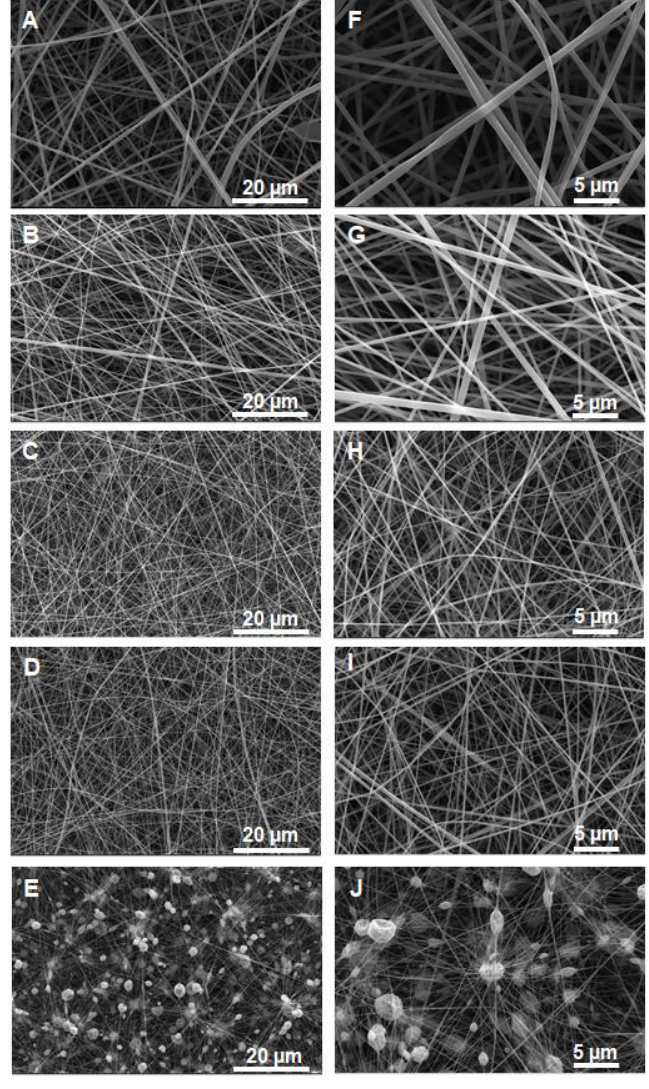
Figure 2. FE-SEM micrographs of pristine P4VPy nanofibers ( A ) and P4Vpy/PP4VpyNTf 2 − nanofibers with PIL compositions of 10 ( B ), 20 ( C ), 30 ( D ), and 50% w / w ( E ). ( F – J ) the same with higher resolution.